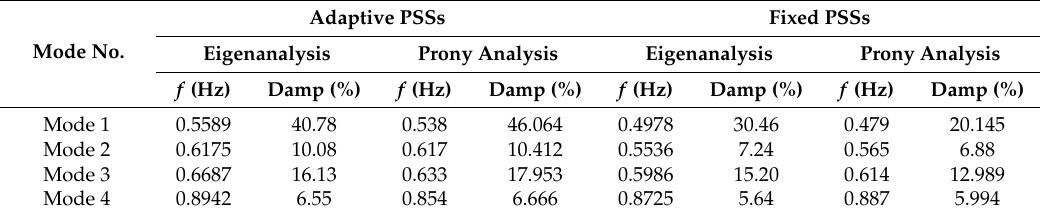
Table 4. Prony analysis and eigenanalysis results.